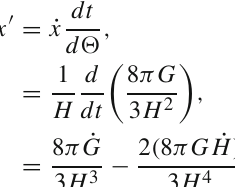
Fig. 15 The plot for EoS, ω de versus redshift, z r for the cosmological model in case II for the considered value of E 2 = ρ (cid:2) and γ = 1